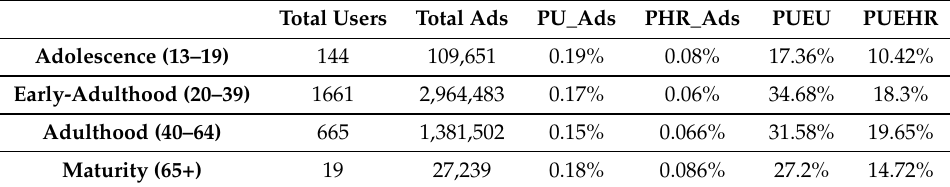
Table 4. This table shows for age groups 13–19 (Adolescence), 20–39 (Early-Adulthood), 40–64 (Adulthood) and 65+ (Maturity) the following information: (i) the number of users, (ii) the number of ads, (iii) the percentage of unsafe ads (PU_Ads), (iv) the percentage of highly risky ads (PHR_Ads), (v) the percentage of users exposed to unsafe ads (PUEU), and (vi) the percentage of users exposed to highly risky (PUEHR). Total Users Total Ads